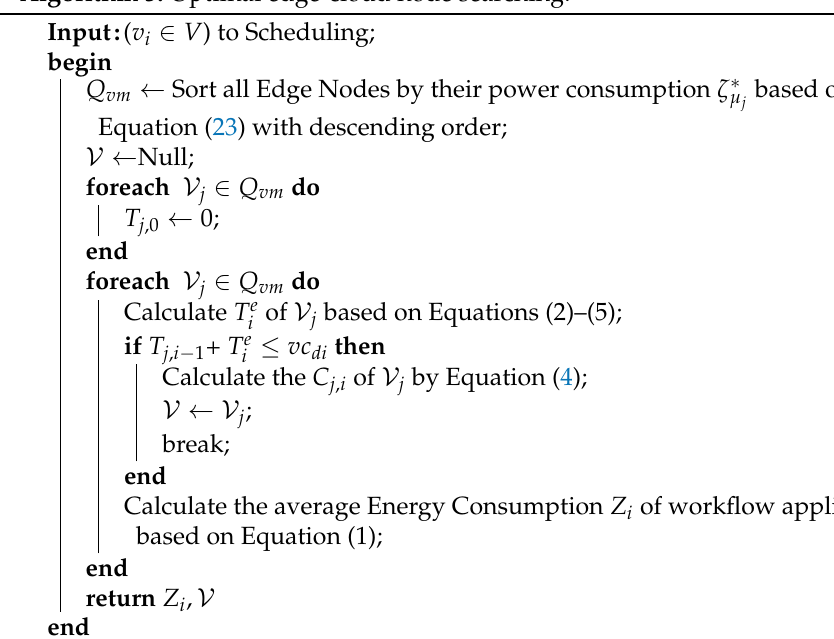
Algorithm 3: Optimal edge-cloud node